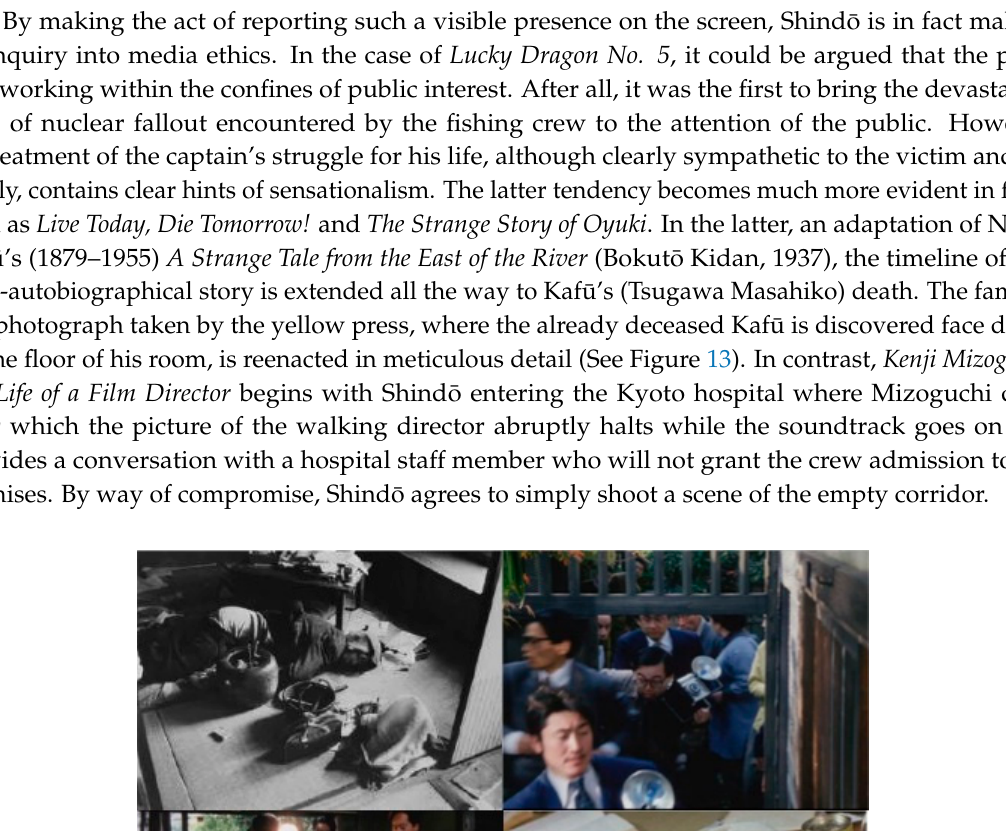
Figure 12. Lucky Dragon No. 5 (Shind ō Kaneto, 1959) .